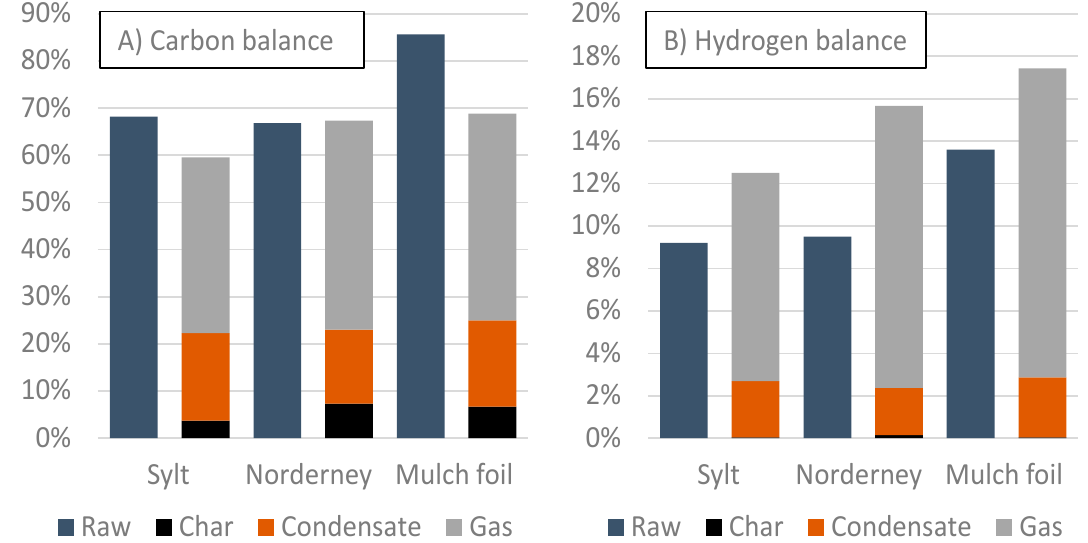
Figure 13. Elementary balances of pyrolysis products compared to analysed content in raw material. ( A ) carbon distribution across product fractions in wt%. ( B ) hydrogen distribution across product fractions in wt%.